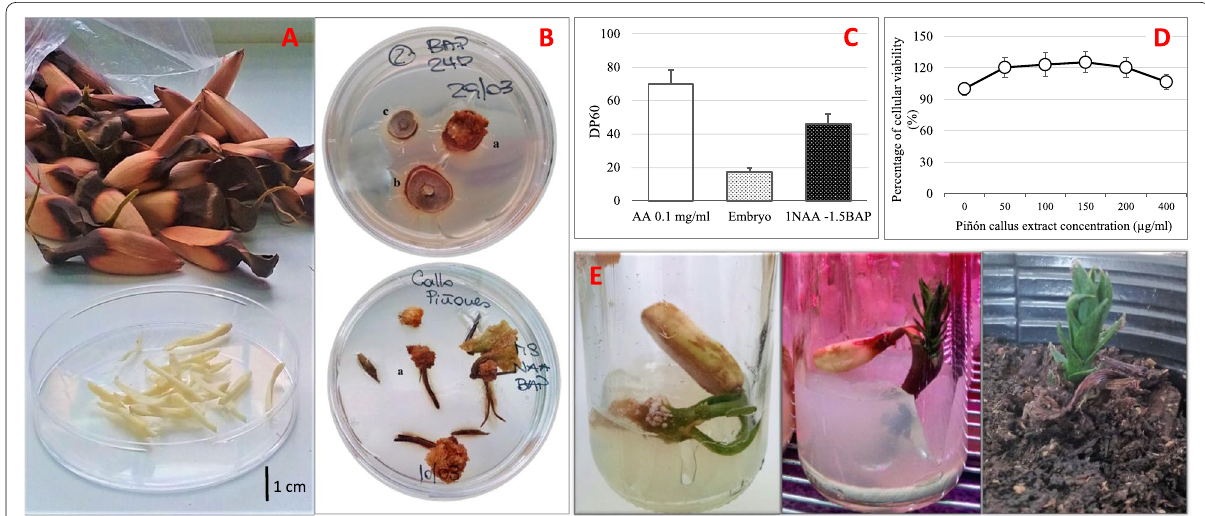
Fig. 1 A Healthy piñones collected from adults trees located near Villa Pehuenia (Neuquén Province, Argentina) and entire embryos separated used for in vitro culture. B Callus formation in piñón slides (up) and isolated embryos (down); where a are callus grown in embryonic axis, b and c are slides of cotyledons and endosperm with no callus formation. Photos correspond to callus 45 days old in 60 mm Petri dishes. C Antioxidant capacity of ascorbic acid solution, embryo, and callus obtained in MS medium supplemented with 1 mg/l NAA and 1.5 mg/l BAP, in light conditions. Results obtained by DPPH assay are expressed as percentage inhibition of DPPH radical at 60 s (DP 60 ). Different letters indicate statistically significant differences. D Effect of different concentrations of callus extract (grown in MS medium with 1.5 mg/l BAP and 1 mg/l NAA in light conditions) on VERO cells viability. Values are expressed as % with respect to control cells (100%). E Representative photos of stages of in vitro germination (left), establishment (middle) and acclimatization (right) of A. araucana